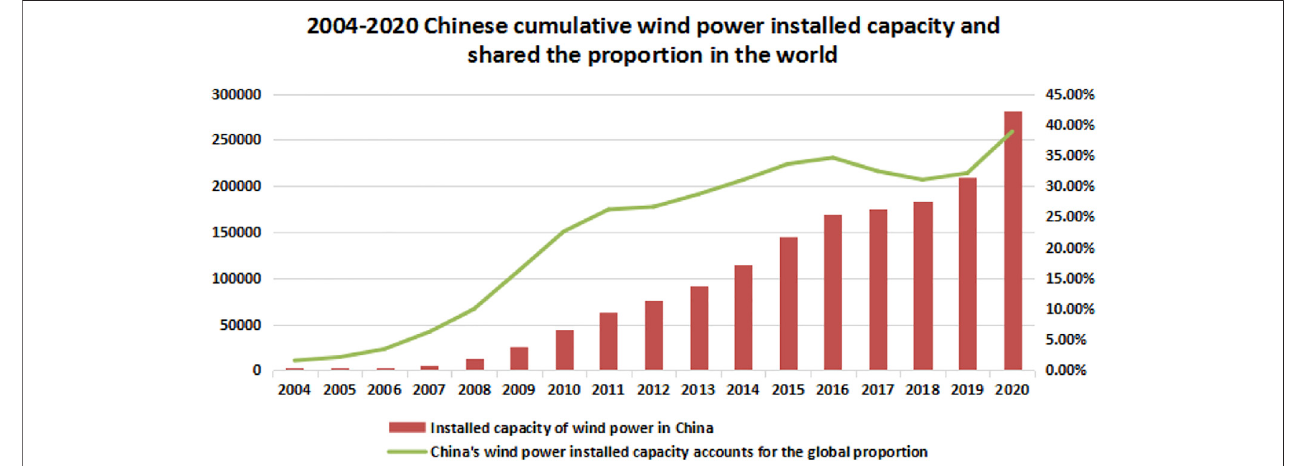
FIGURE 1 | Installed wind power in China and its proportion in the world from 2004 to 2020 (unit: MW).